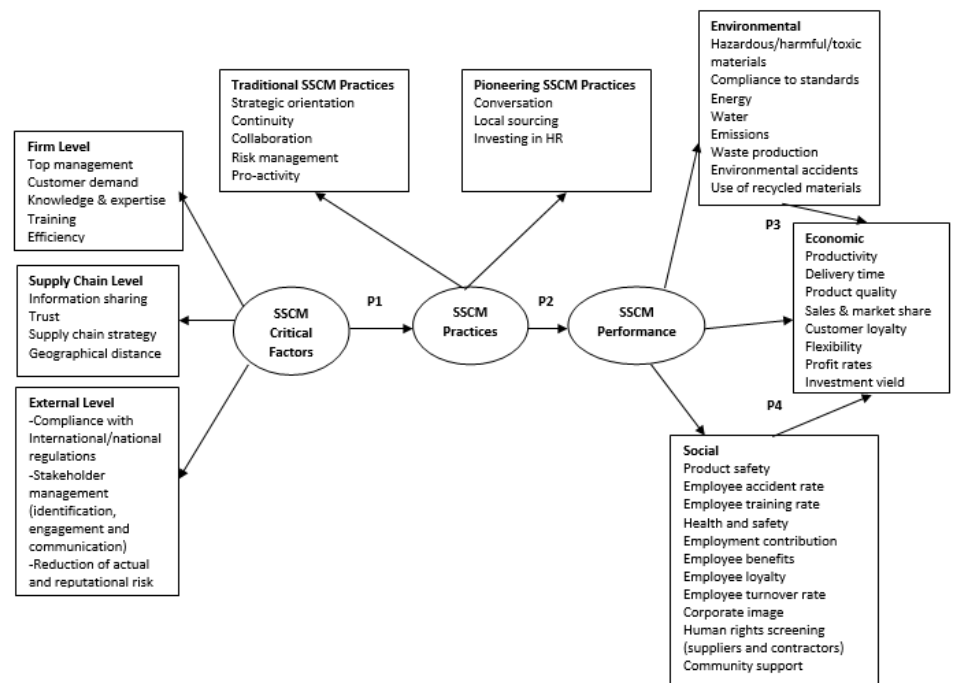
Figure 3. Conceptual model of sustainable supply chain management in the food industry.